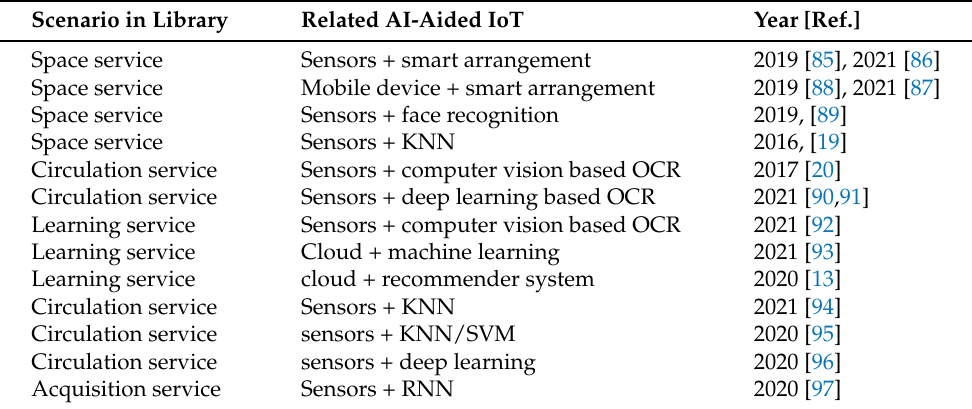
Table 2. The surveyed literature on AI-aided IoT applied in smart library service. Scenario in